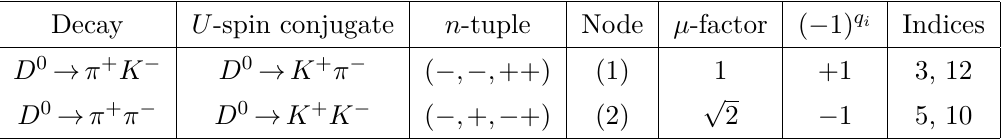
Table 3 . The mapping of the U -spin amplitude pairs of D 0 → P + P − decays into generalized n